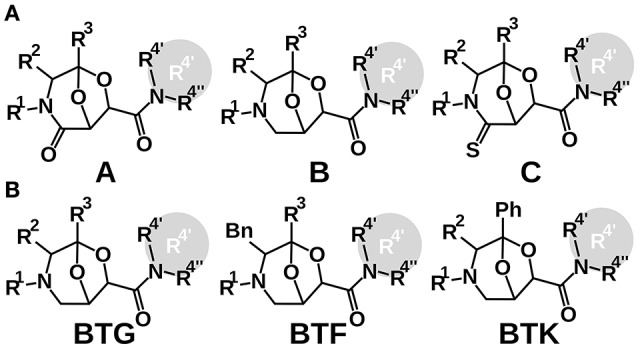
Two classifications of the scaffolds the chemical library is built on. (A) BTA(O), BTA and BTA(S); (B) BTK, BTF, and BTG. When a compound bore a cyclic residue at position R4′ and R4″, it was annotated as R4′.